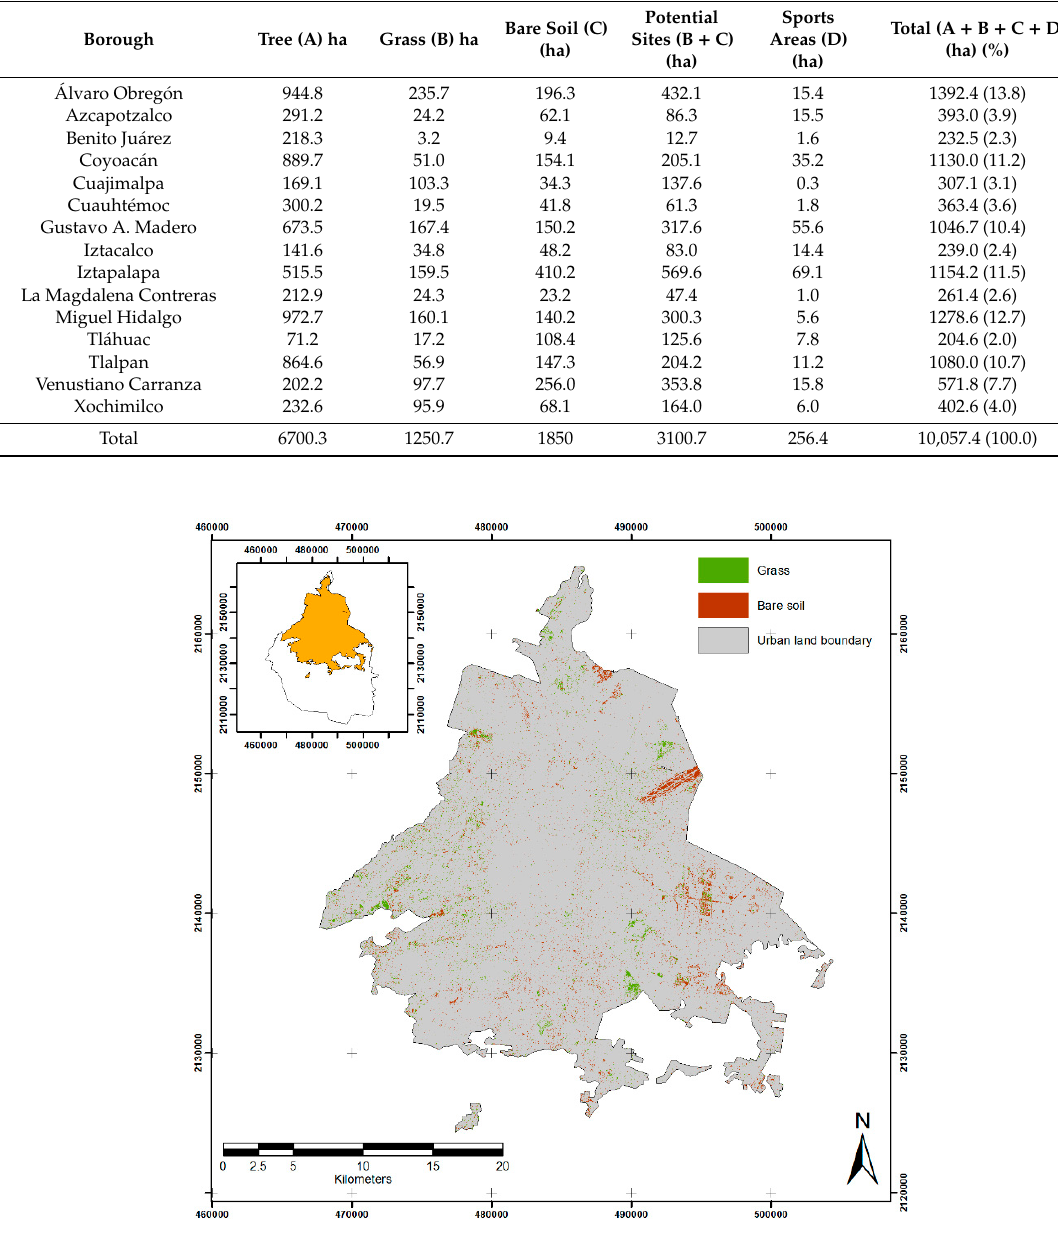
Borough area of potential planting sites, while the borough of Benito Ju á rez has the smallest available area, with 569.6 ha and 12.7 ha, respectively (Table 3). Table 3. Potential planting area and total green area in Mexico City’s boroughs.